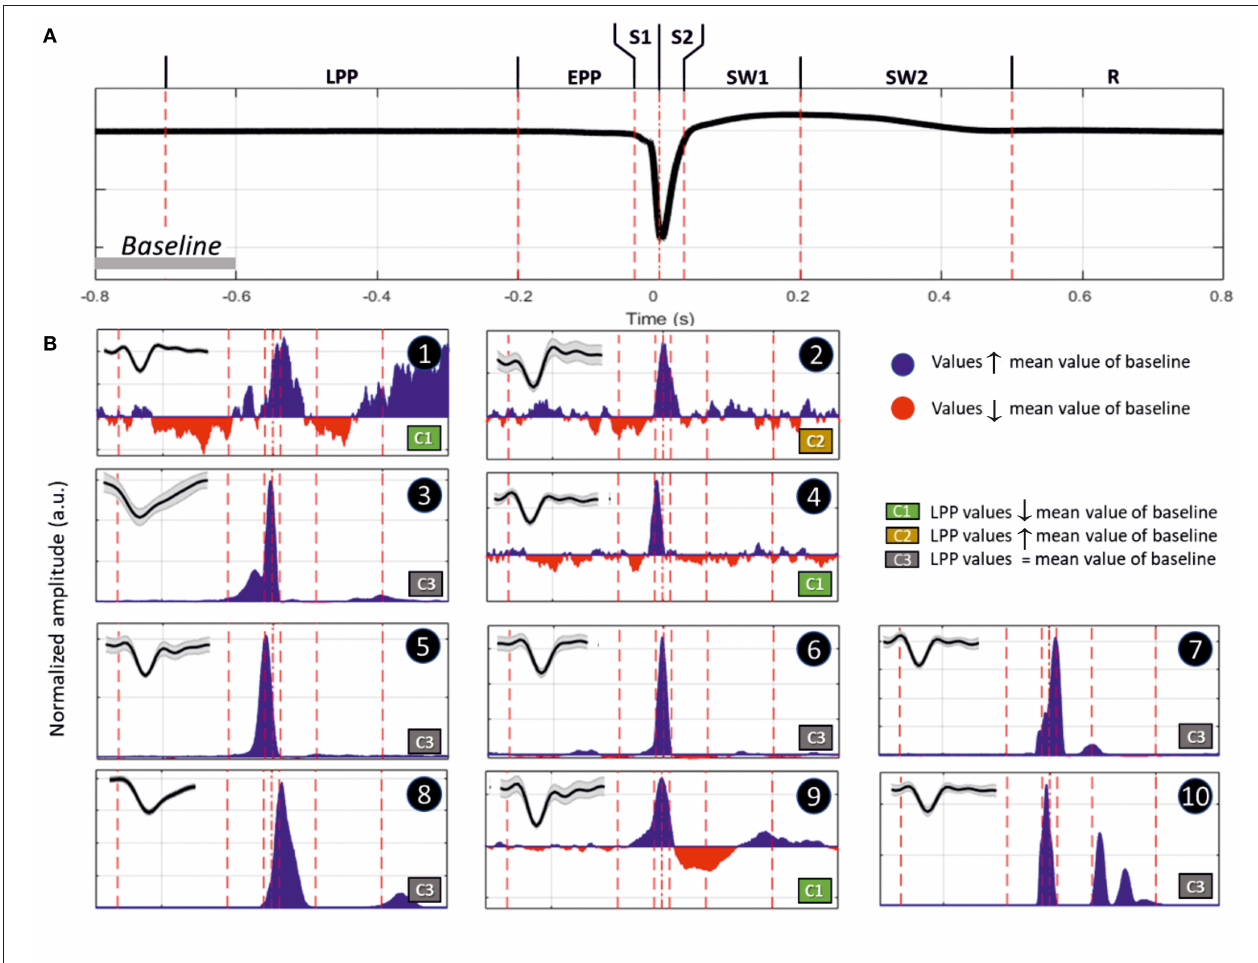
FIGURE 9 | (A) Representation of an IIS, highlighting the reference periods (discontinuous vertical red lines at − 700, − 200, − 35, 0, + 35, + 200, and + 500ms), with T0 corresponding to the peak of the IIS. (B) Representative examples of differences in spike discharges occurring in the different periods (Inlet, shape of the unit activity with its standard deviation): Period 1 (LPP, − 700 to − 200ms), B1 and B2; Period 2 (EPP, − 200 to − 35ms), B3 and B4; Period 3 (S1, − 35 to 0ms), B5; Period 4 (S2, 0 to + 35ms), B7; Period 5 (SW1, + 35 to + 200ms), B8 and B9; and Period 6 (SW2, + 200 to + 500ms), B10. Period 7 (R, return to baseline). The blue and red areas represent values that are higher or lower than those of the mean of the baseline ( − 800 to − 600ms). The classification was performed according to the firing rate of Period 1. Class 1 (C1), increase; Class 2 (C2), decrease; and Class 3 (C3), no